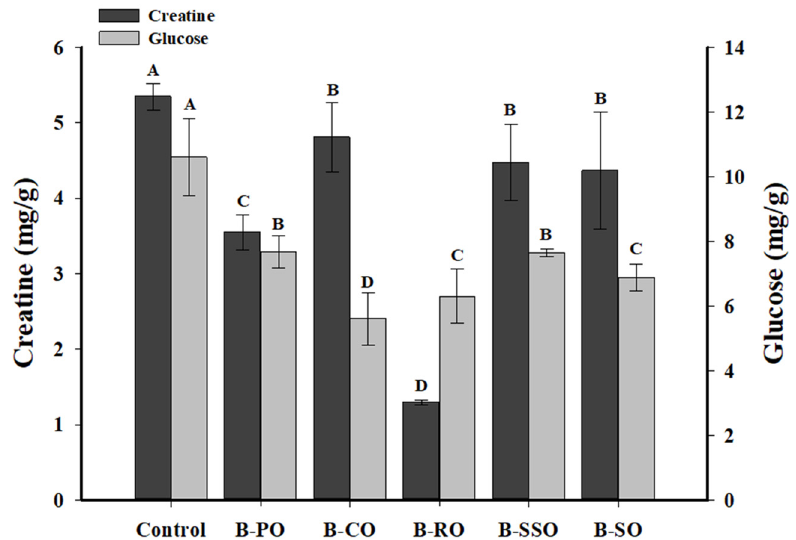
Figure 1. Chang of creatine and glucose in fried bacon using different oils. Significant differences ( p < 0.05) within same index are represented by different uppercase letters (A–D). Control, unfried bacon; B–PO, bacon fried in peanut oil; B–CO, bacon fried in corn oil; B–RO, bacon fried in rapeseed oil; B–SSO, bacon fried in sunflower seed oil; B–SO, bacon fried in soybean oil. Table 2. Chang of FAAs (ug/g) in fried bacon using different vegetable oils. Control B–PO B–CO B–RO B–SSO B–SO Asp